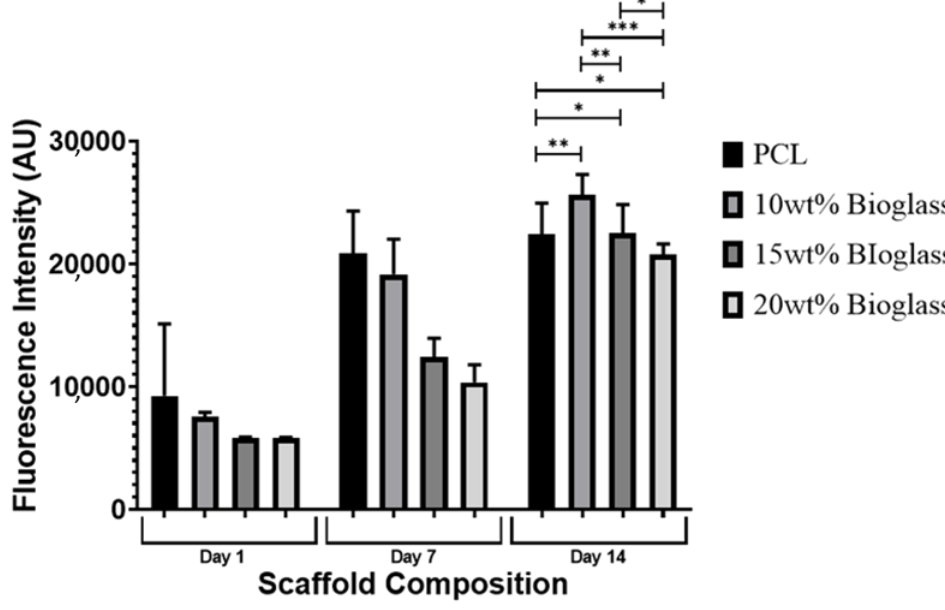
Figure 12. The average fluorescence intensity for the different scaffolds at different days after cell seeding. * Statistical evidence ( p < 0.05) analysed by one-way ANOVA, and Tukey post hoc test. The * Statistical evidence ( p < 0.05), **, *** and **** is the one-way analysis of variance (one-way ANOVA) and Tukey’s post hoc test with the use of GraphPad Prism software and is used to show the difference between the results. The * is a small difference, while more * are added as the differences between the results increase. Table 6. The element composition of the 3D printed scaffolds at day 14 after cell seeding.